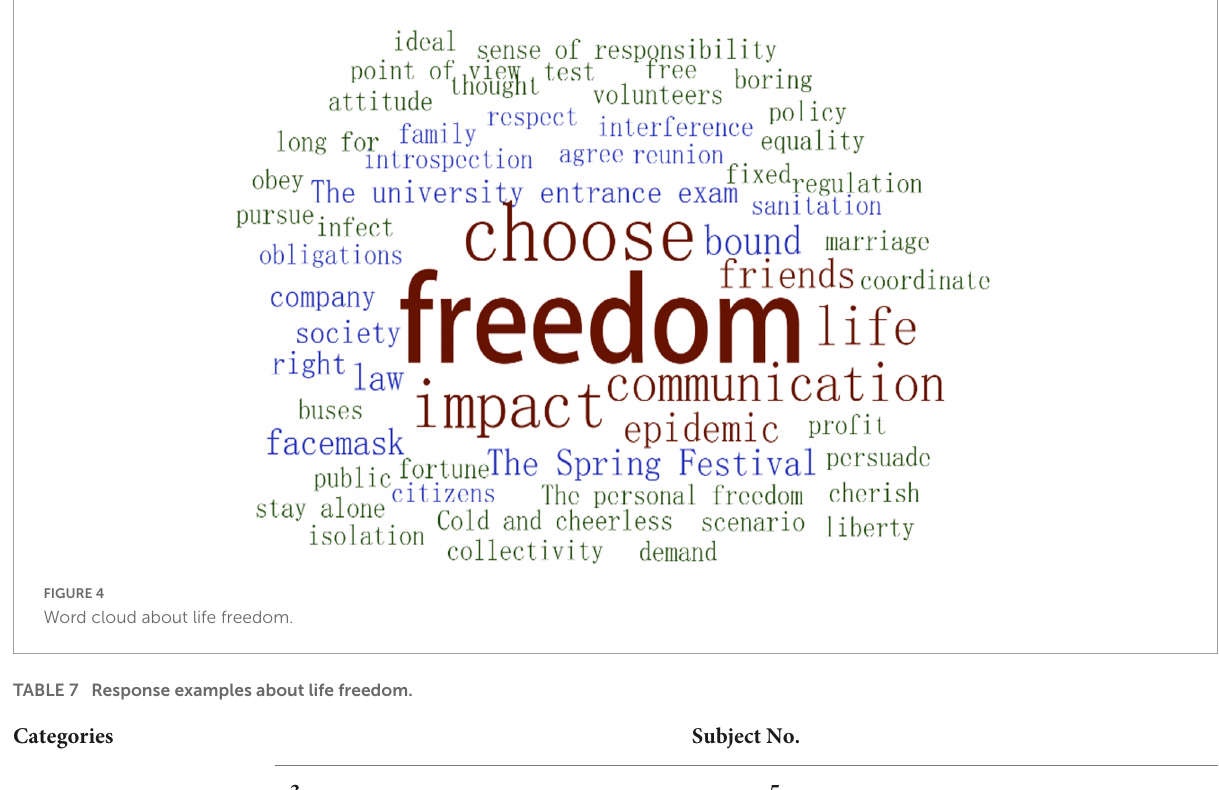
TABLE 7 Response examples about life